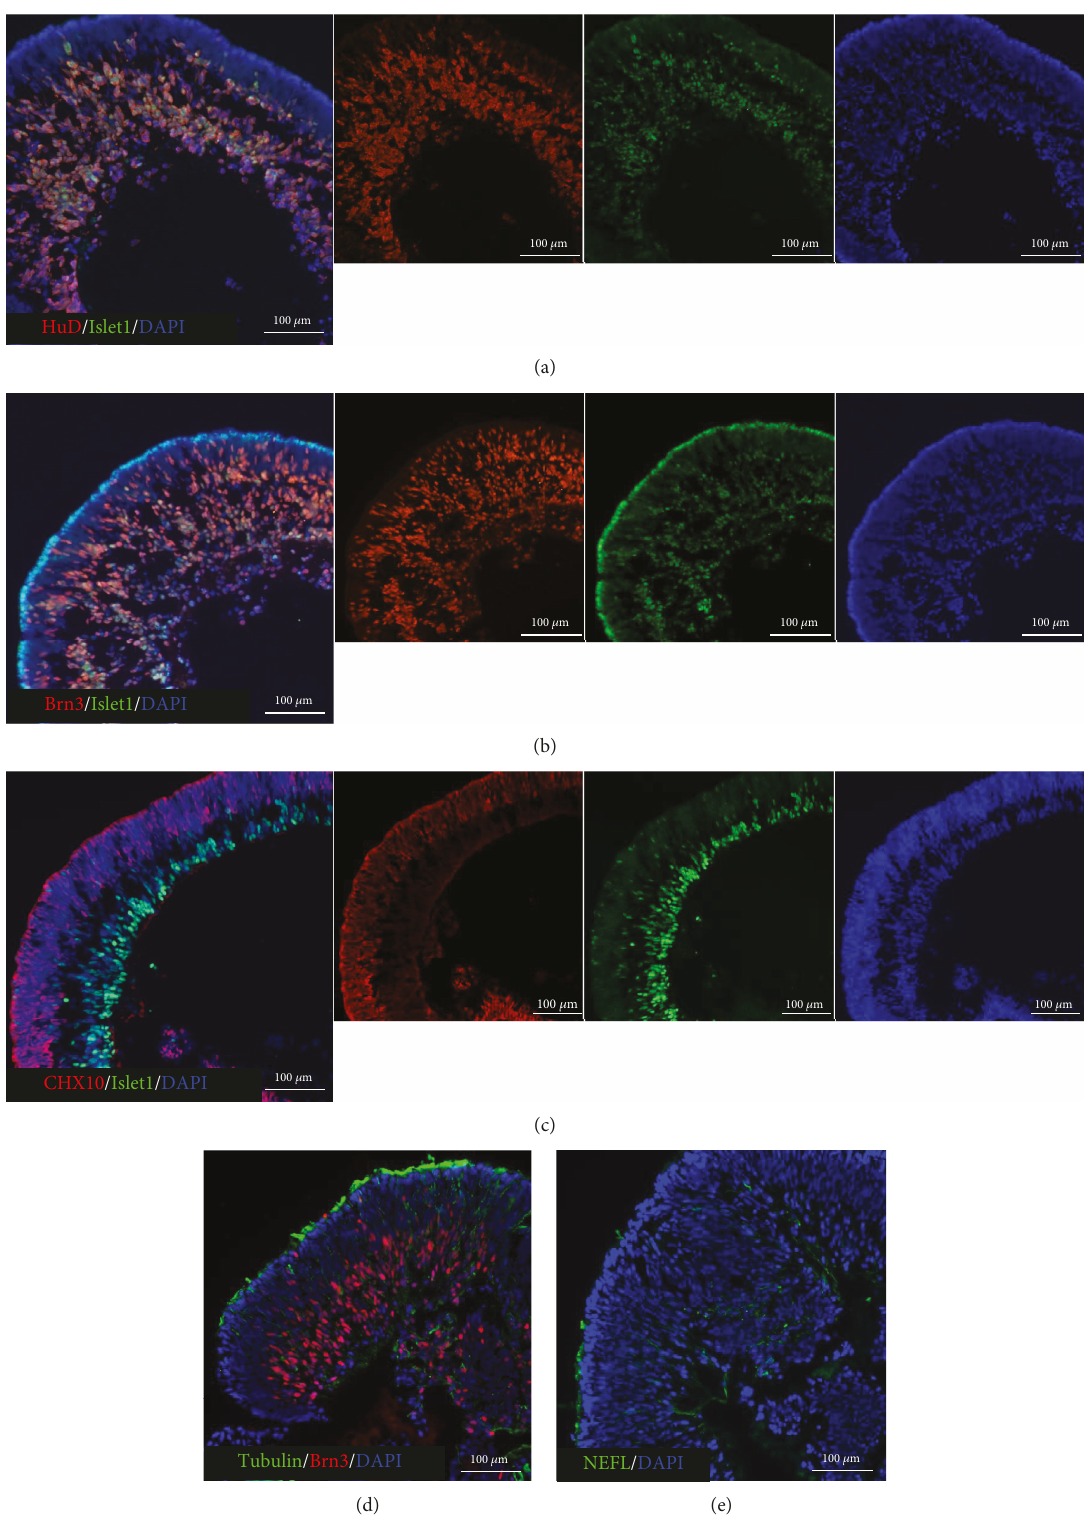
Figure 1: Characteristics of retinal organoids after 30-45 days of induction. The frozen sections of retinal organoids were identi fi ed by immuno fl uorescence staining. (a, b) At this time, most cells of the organoids were di ff erentiating towards RGCs; they were Islet1-, Brn3- and HuD-positive. (c) But some cells outside were still retinal progenitors; they were CHX10-positive. (d, e) And in suspension cultivation, little axons were